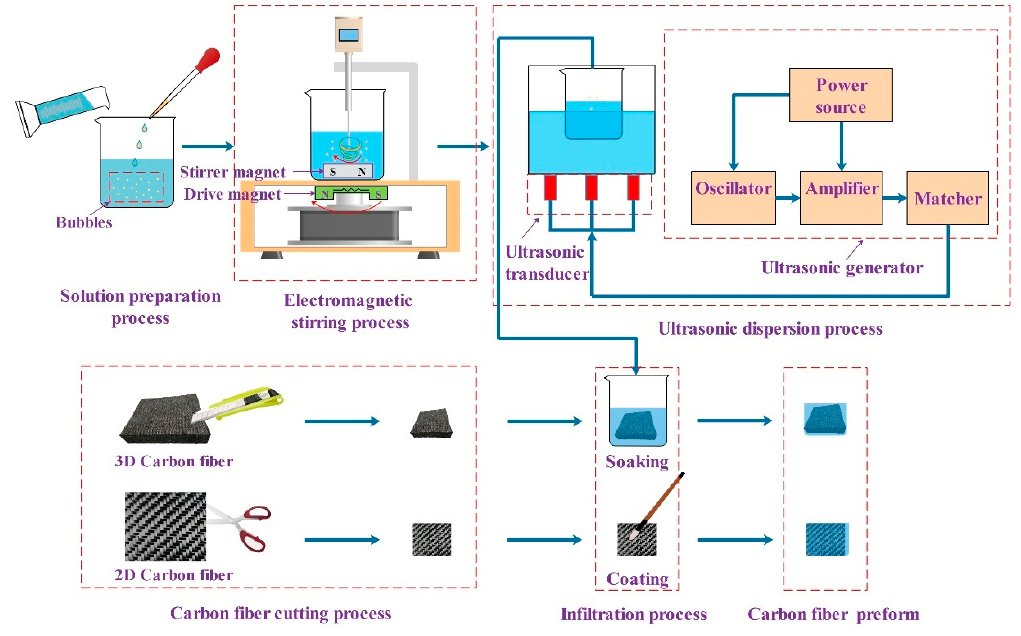
Figure 2. Flowchart of carbon fiber pre-forming